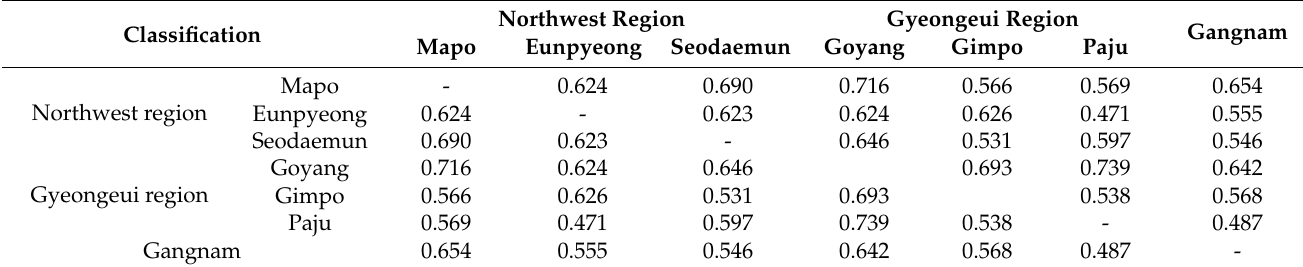
Table 4. Correlation analysis of jeonse price between individual cities.